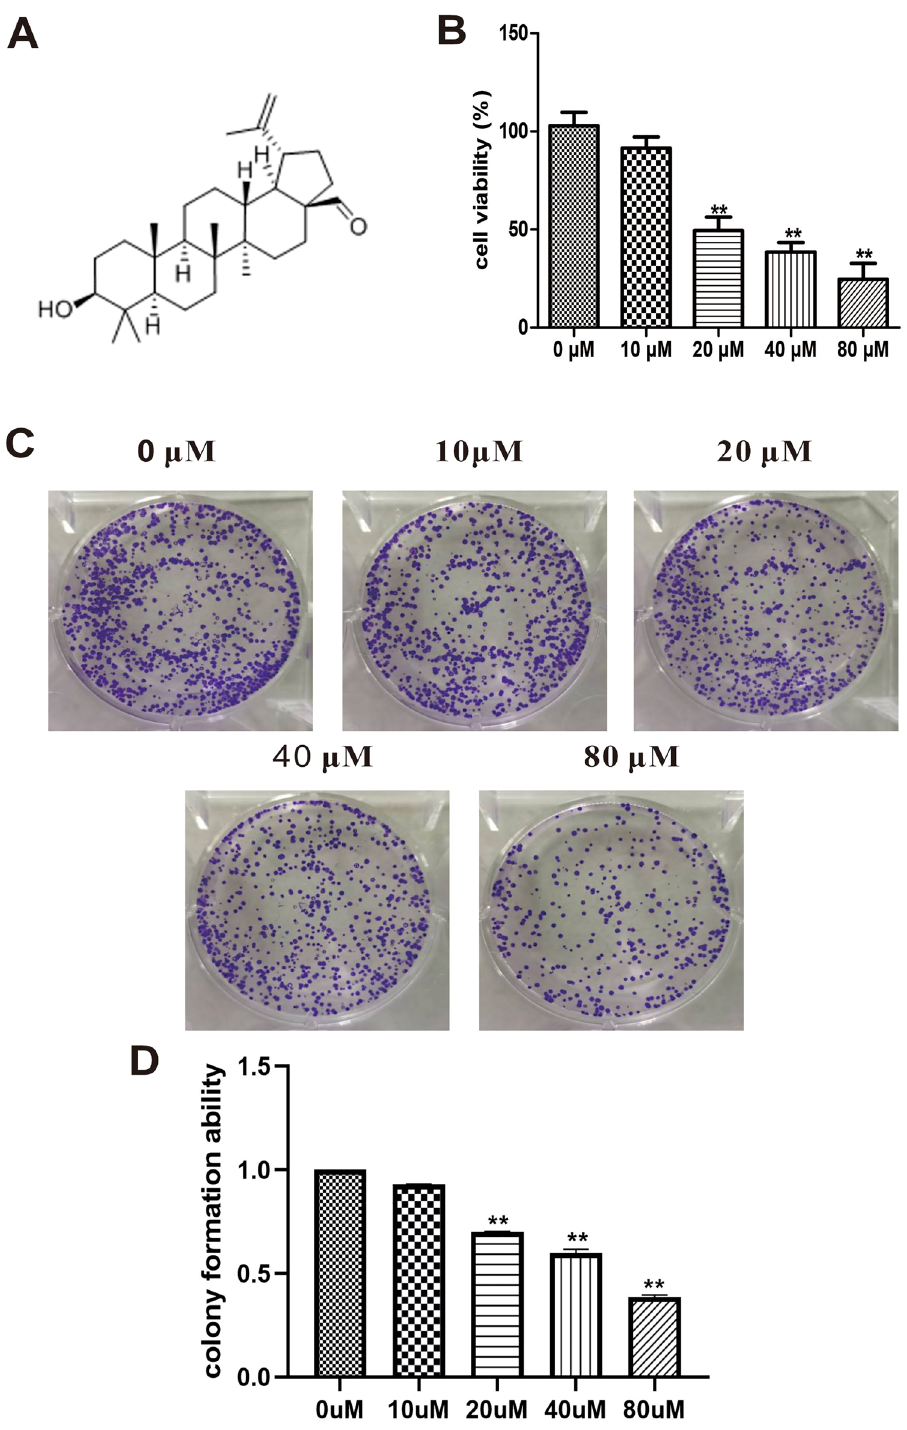
Figure 1. Betulinaldehyde inhibited the viability and colony formation of A549 cells. ( A ) The chemical structure of betulinaldehyde. ( B ) A549 cells were treated with different concentrations of betulinaldehyde for 24 h and the cell viability was detected via CCK8. ( C , D ) The colony formation ability was detected via crystal violet staining. All values are expressed as the mean ± SD ( n = 3). Statistical significance was evaluated by one- way analysis of variance followed by LSD for post hoc test. ** P < 0.01 versus 0 μM